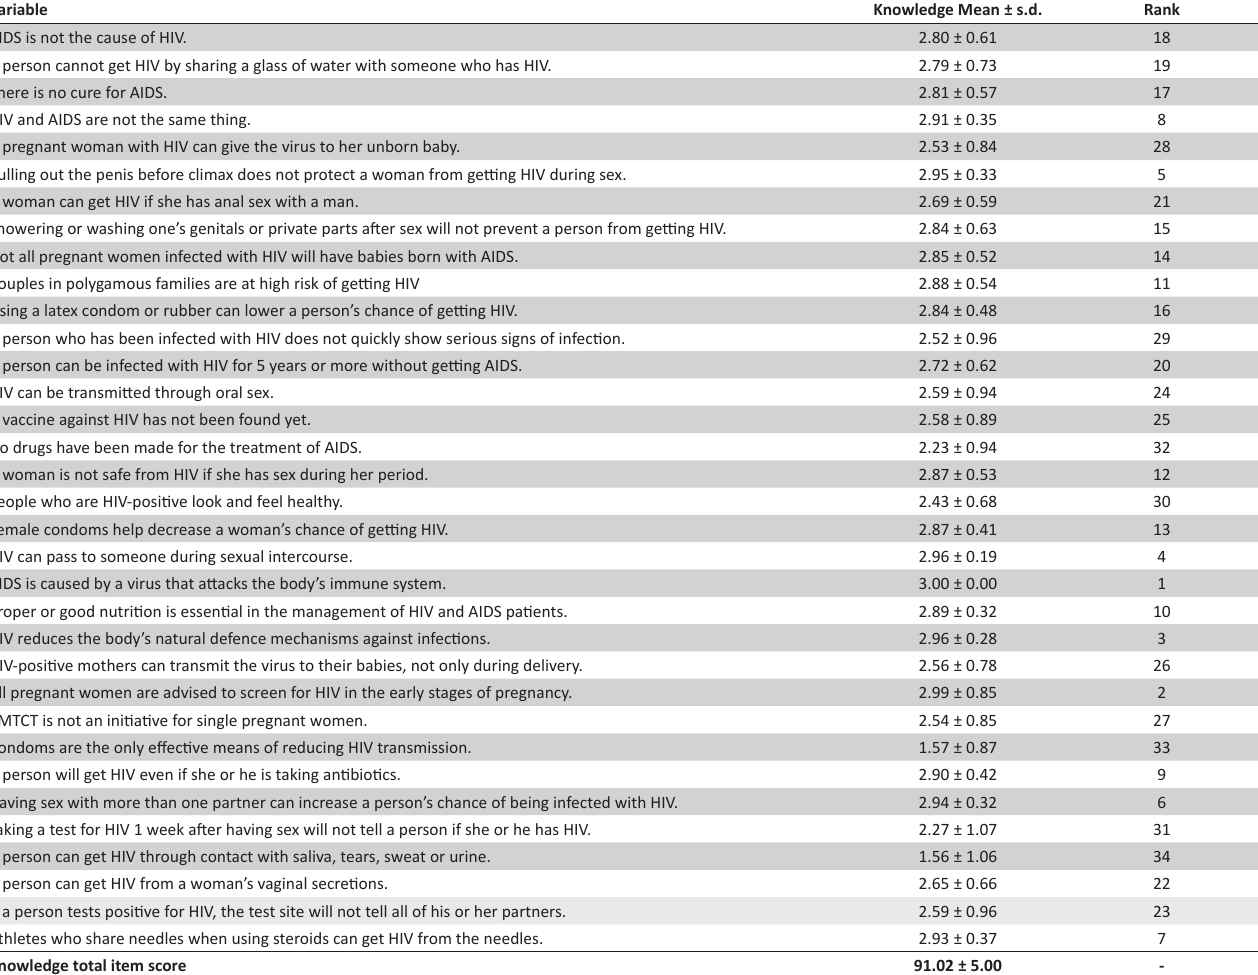
TABLE 3: Students’ knowledge descriptive statistics ( n = 140).